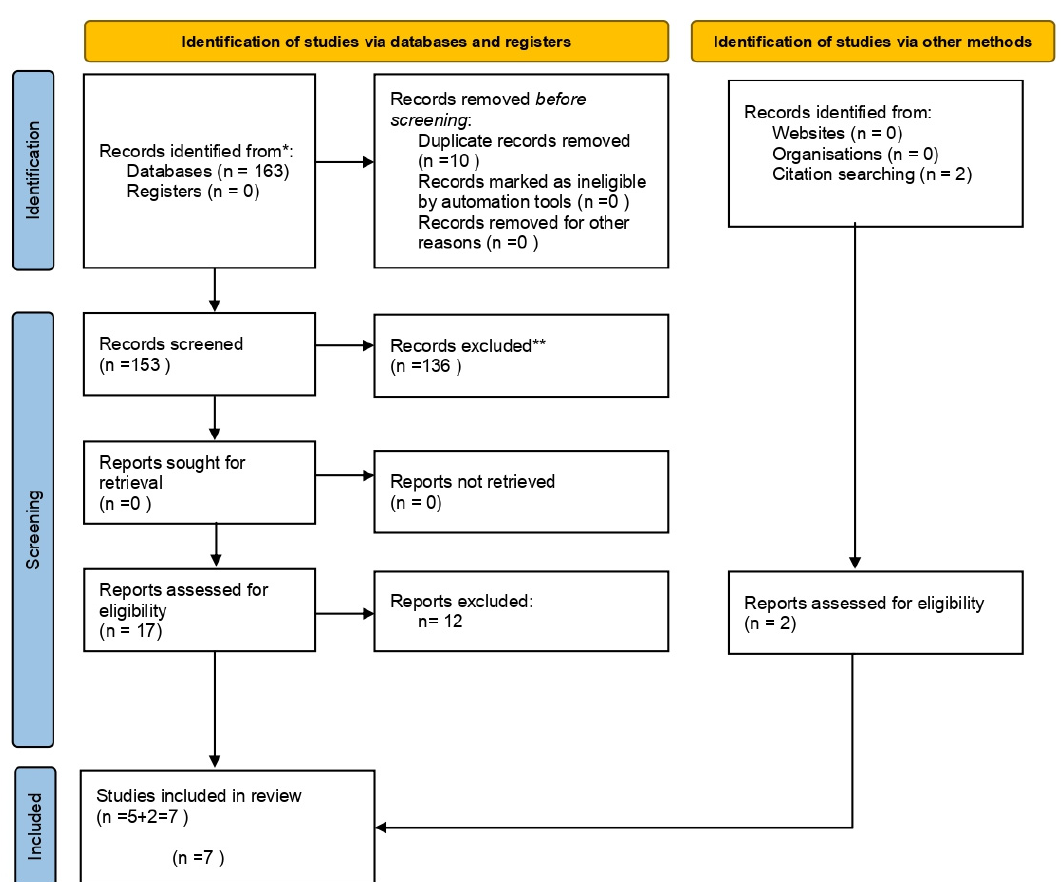
Figure 1. Systematic flow diagram representing the inclusion of studies according to the PRISMA 2020 Statement [24]. * Consider, if feasible to do so, reporting the number of records identified from each database or register searched (rather than the total number across all databases/registers). ** lf automation tools were used, indicate how many records were excluded by a human and how many were excluded by automation tools.